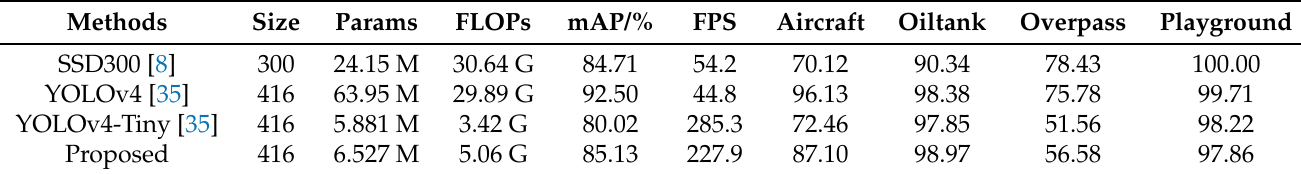
Table 10. Measured detection results on the RSOD